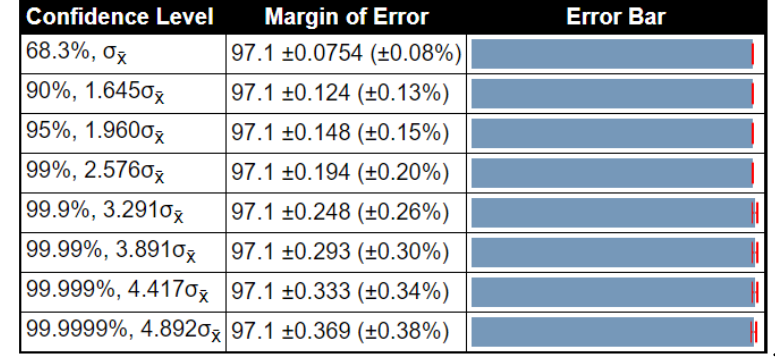
Figure 8. Confidence interval of statistical test for different critical values of t -test (BraTS 2015 dataset).